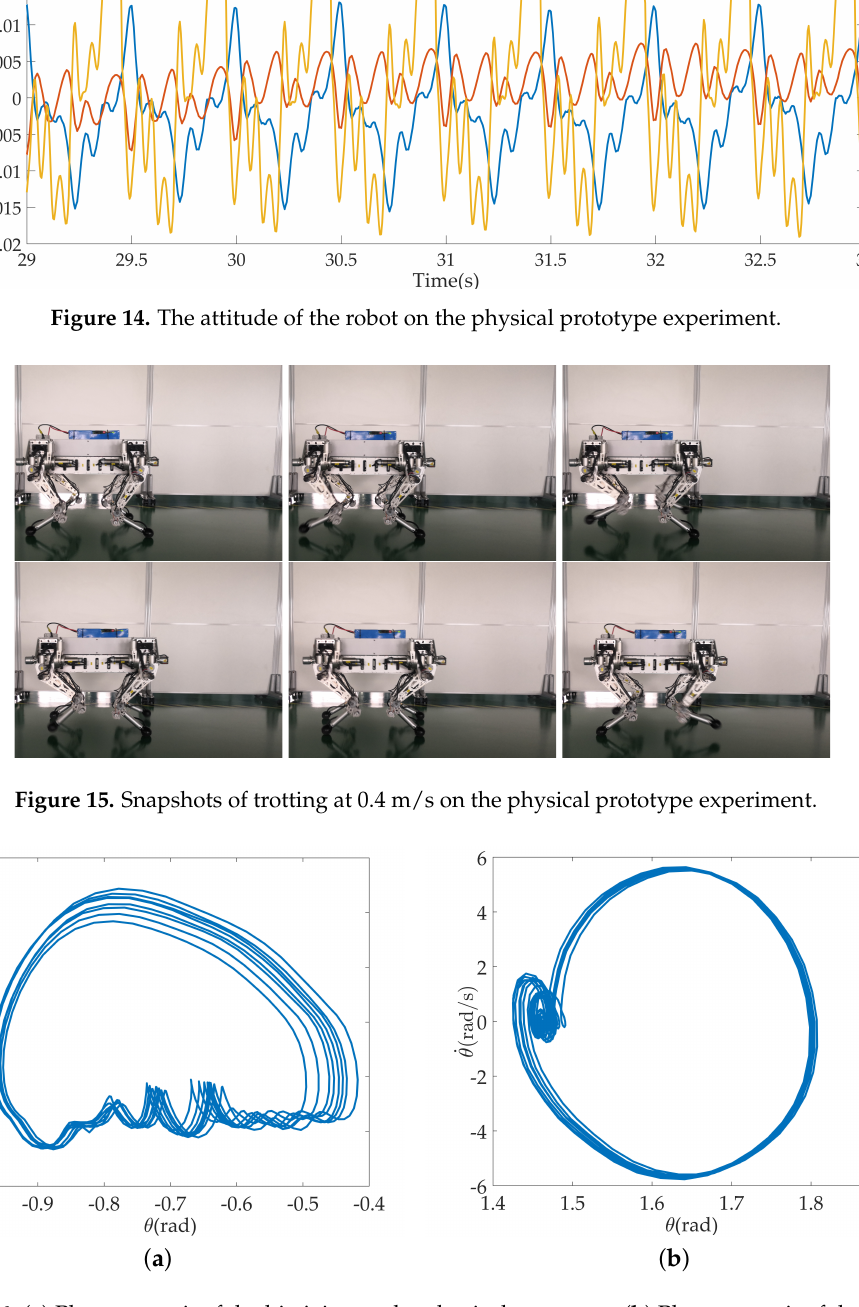
Figure 16. ( a ) Phase portrait of the hip joint on the physical prototype; ( b ) Phase portrait of the knee joint on the physical